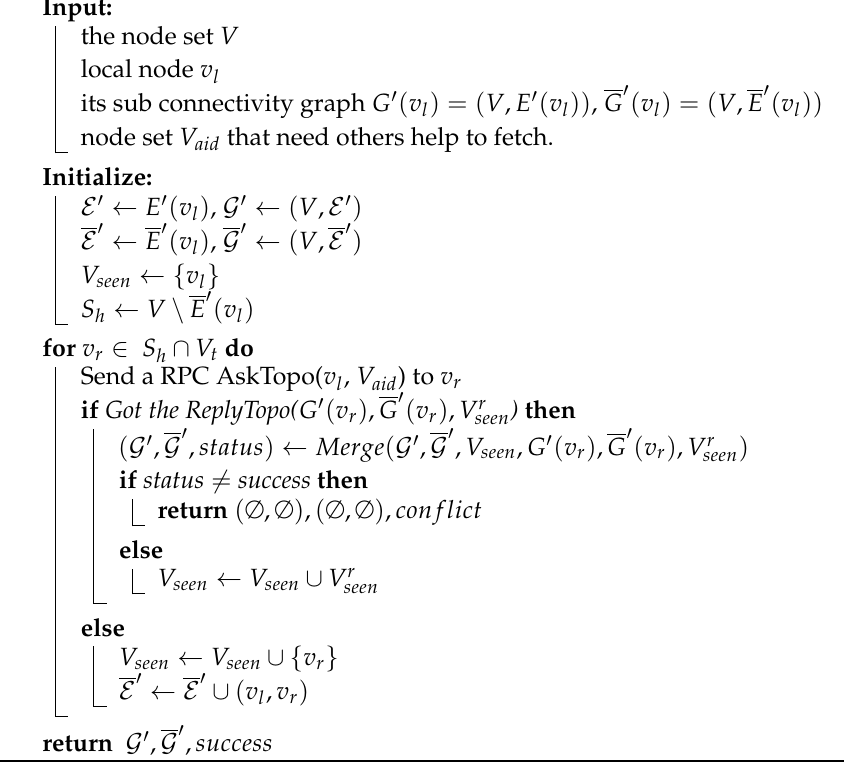
(cid:48) , V t , V aid ).